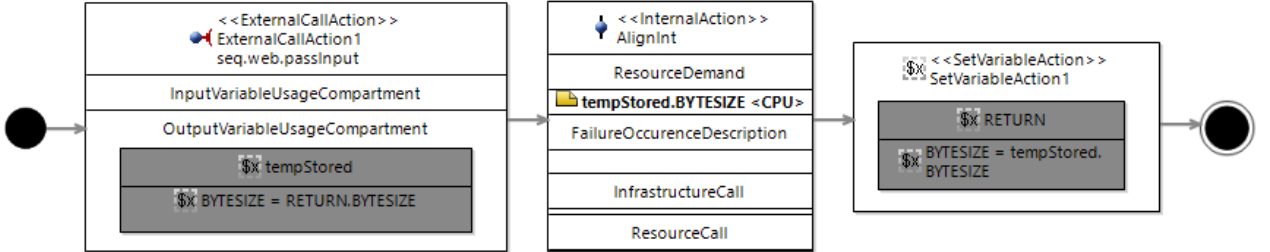
Figure 6. SEFF diagram for the alignSeq signature.